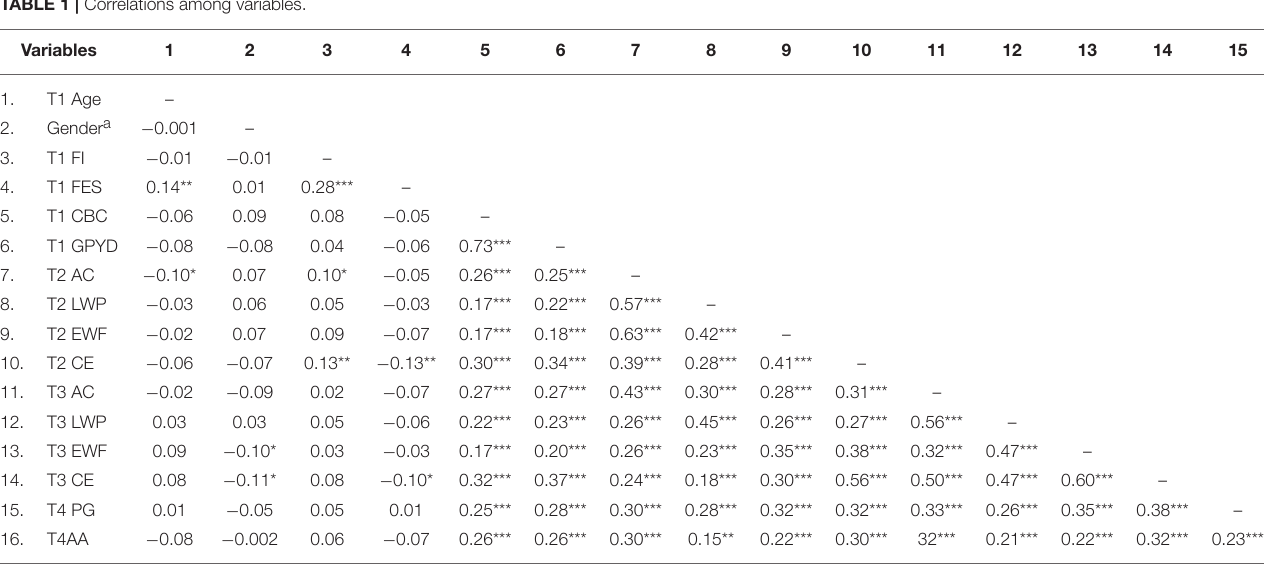
TABLE 1 | Correlations among variables.